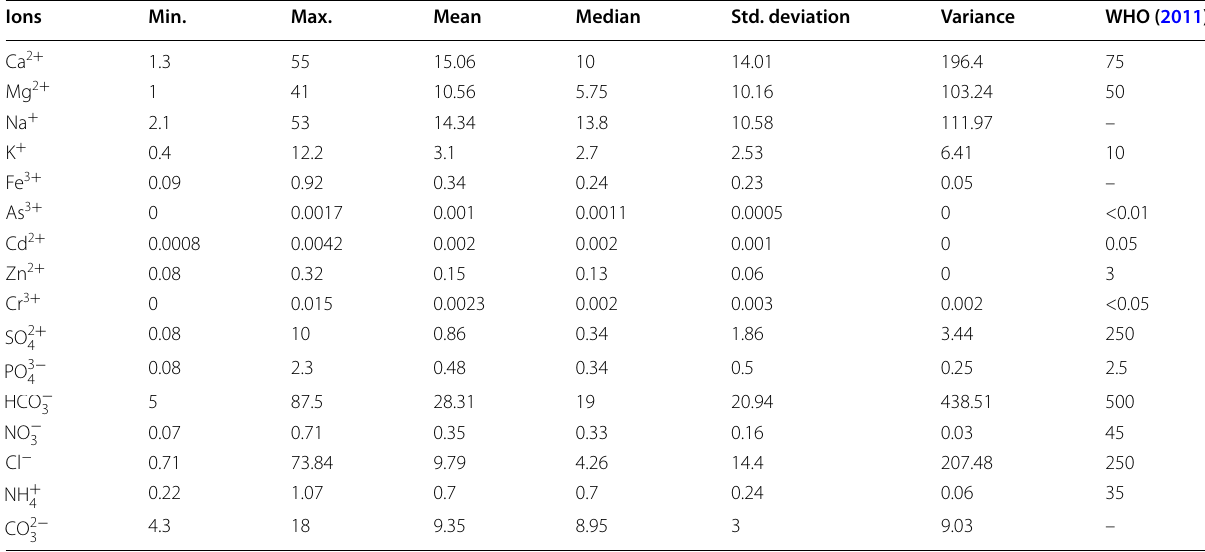
Table 4 Statistical analysis of the ion concentration in water around the study area, Dinajpur Ions